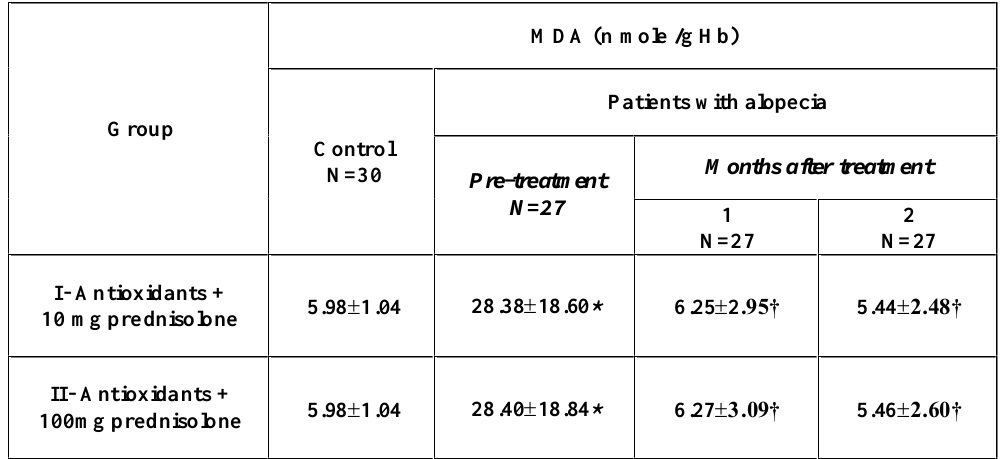
Table (2): Effect of the addition of nutrient antioxidants (A, E, &C) to prednisolone